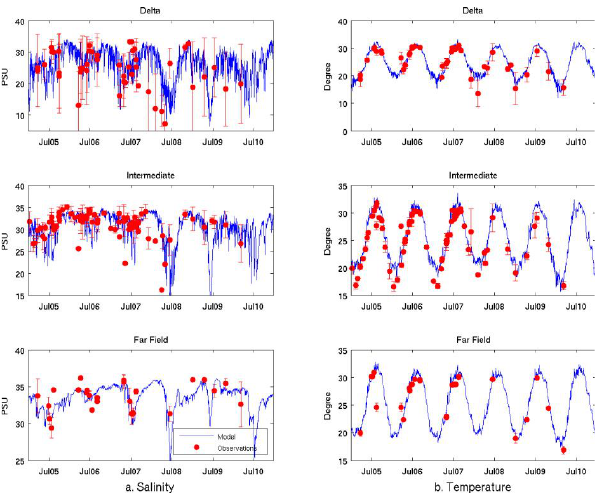
Fig. 6. Time series comparisons between observed and simulated